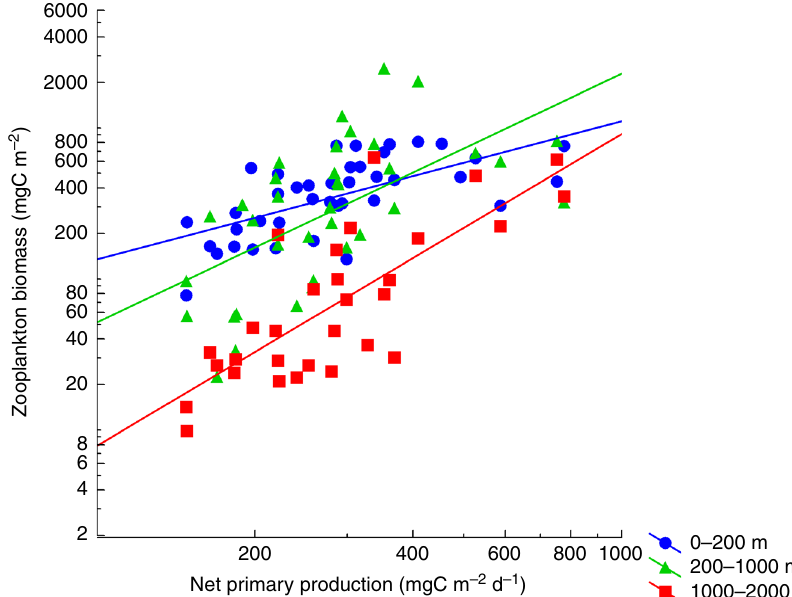
Fig. 2 Zooplankton biomass and primary production. Relationships between net primary production and zooplankton biomass in the epi- (0 – 200 m), meso- (200 – 1000 m), and bathypelagic (1000 – 2000 m) layers during the Malaspina Circumnavigation Expedition. Solid lines represented the fi tted regressions. Note that both axis are in logarithmic scale.